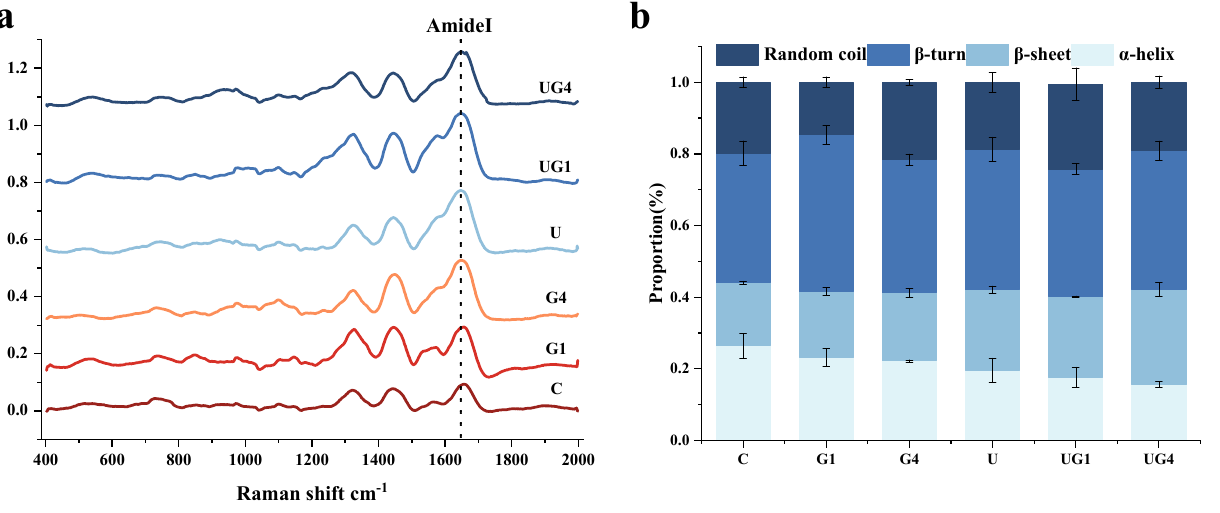
Figure 3. Raman spectra ( a ) and the corresponding secondary structure under different treatment conditions ( b ). C: 3% NaCl; G1: 3% NaCl and 1% glycerol; G4: 3% NaCl and 4% glycerol; U: 3% NaCl with UT; UG1: 3% NaCl and 1% glycerol with UT. UG4: 3% NaCl and 4% glycerol with UT.